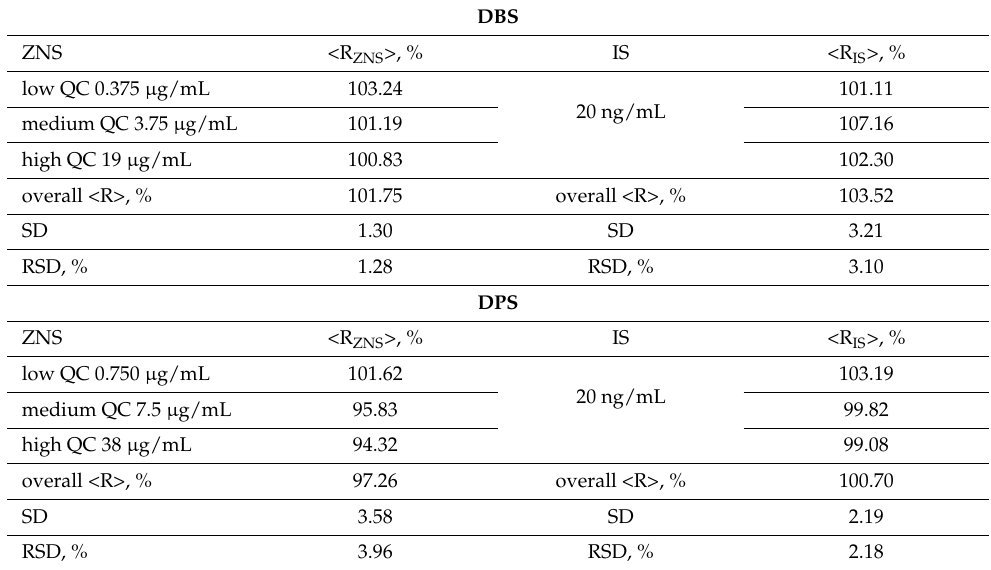
Table 5. Extraction Recovery